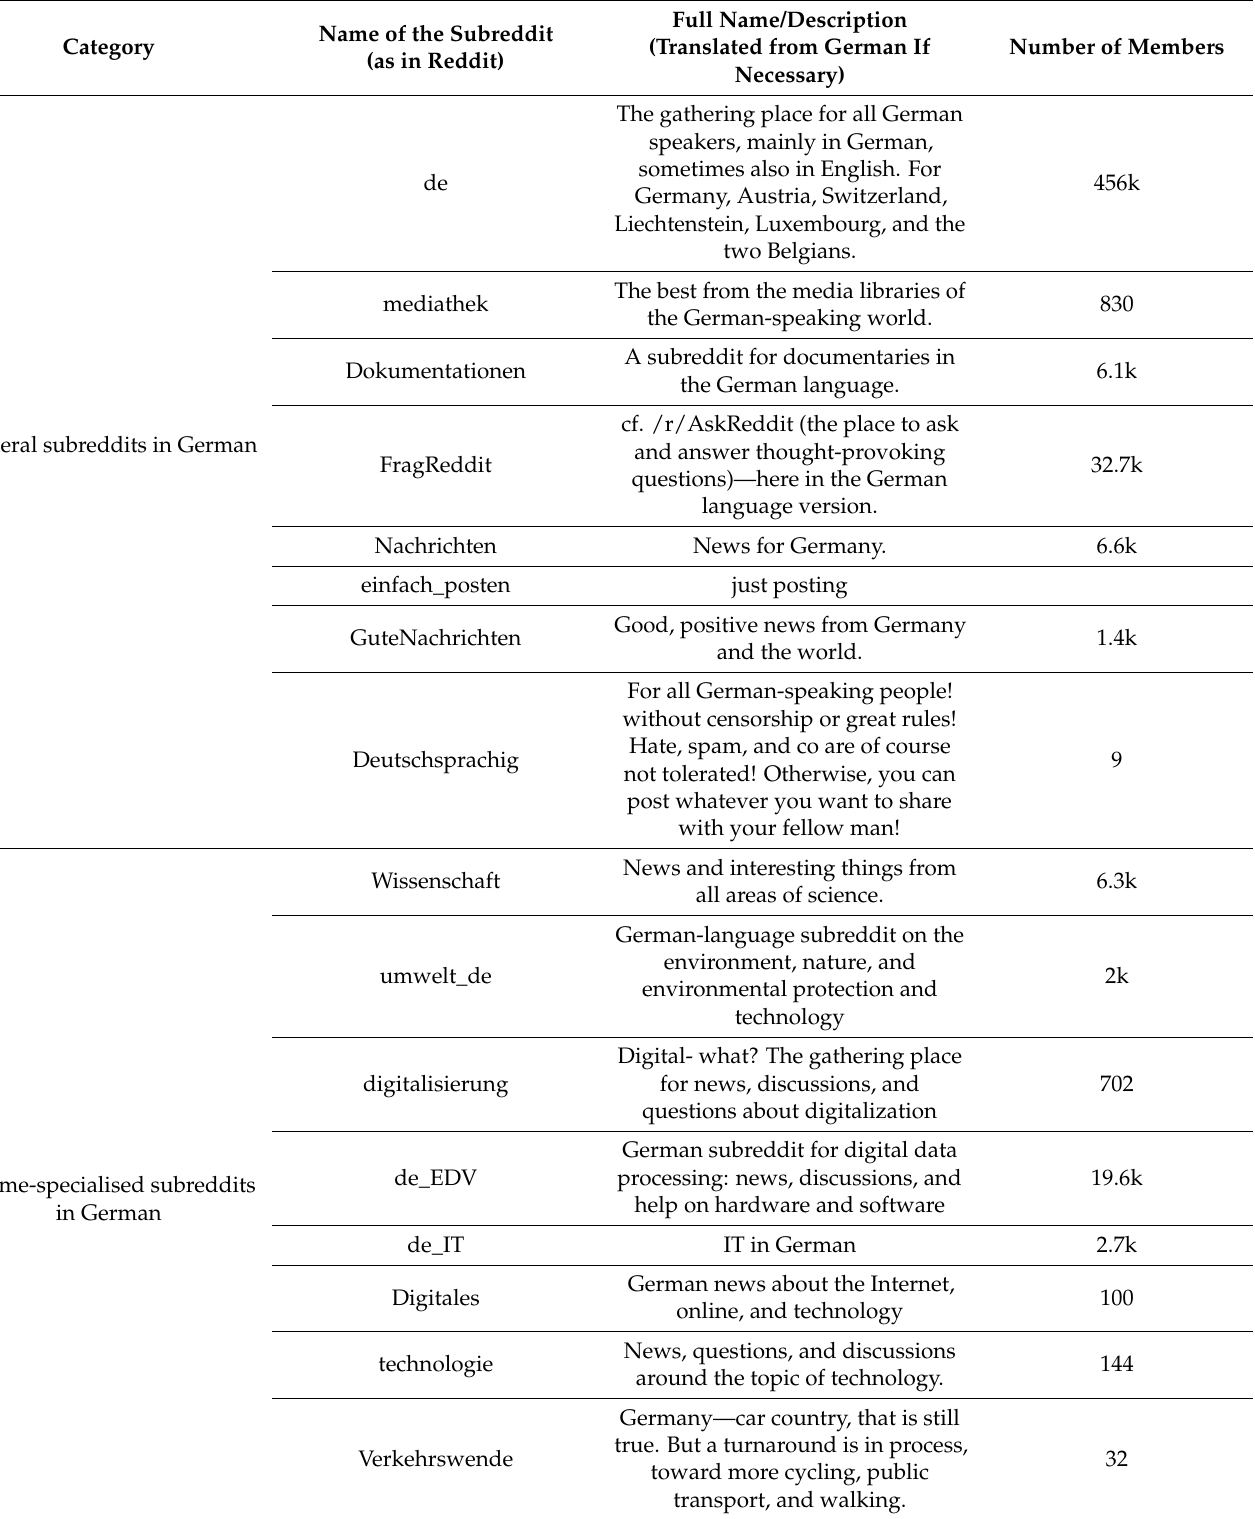
Table A2. “German” subreddits divided into